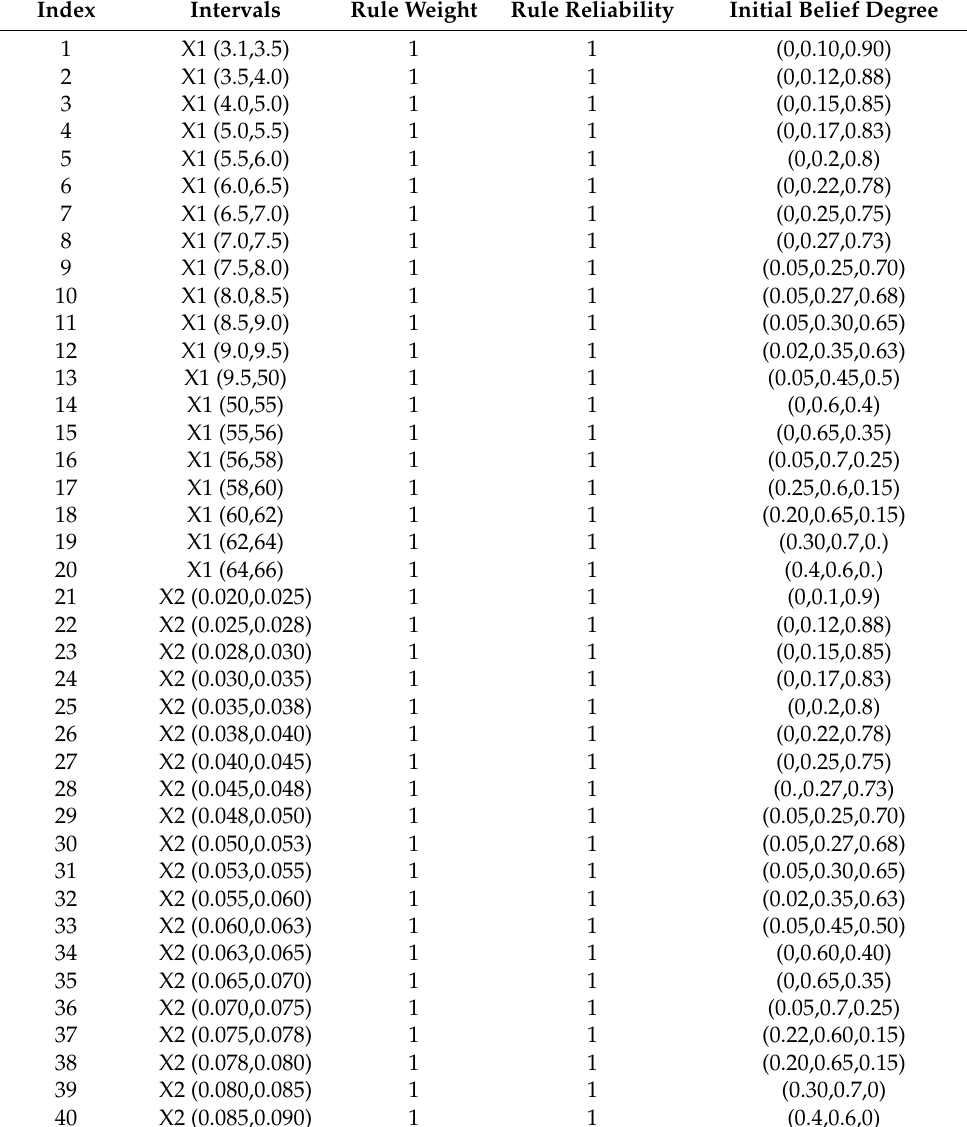
Table A1. The initial rule weight, rule reliability and belief degree of the proposed